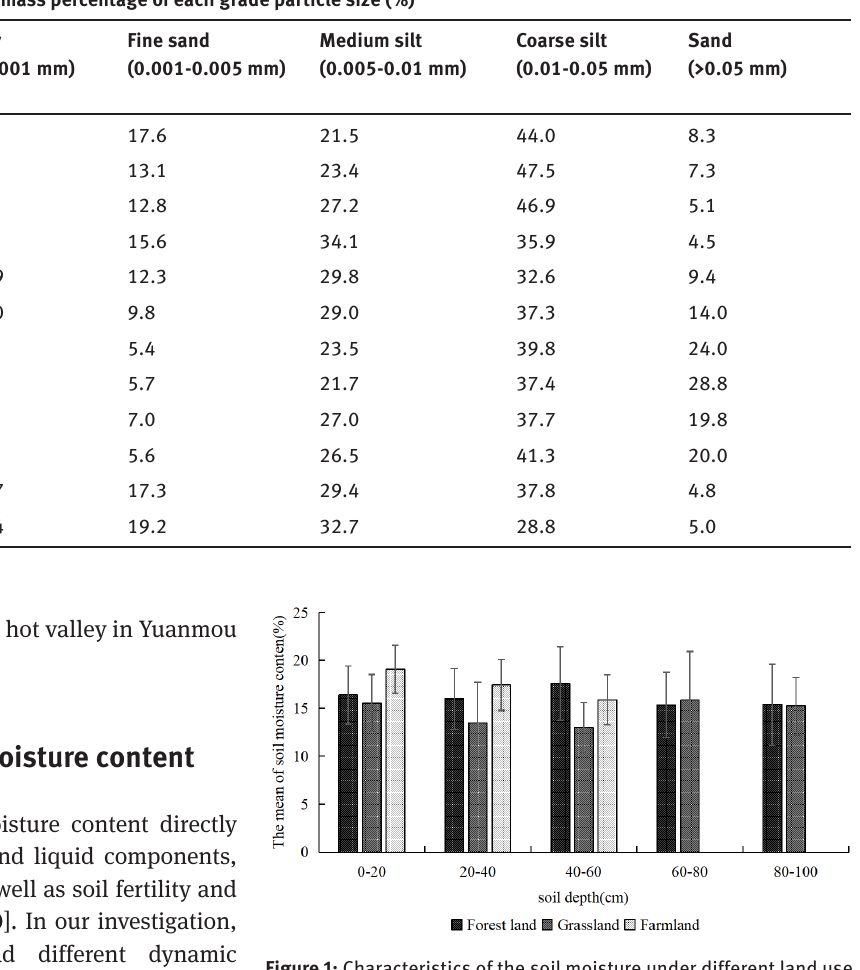
Figure 1: Characteristics of the soil moisture under different land use types at the studied soil